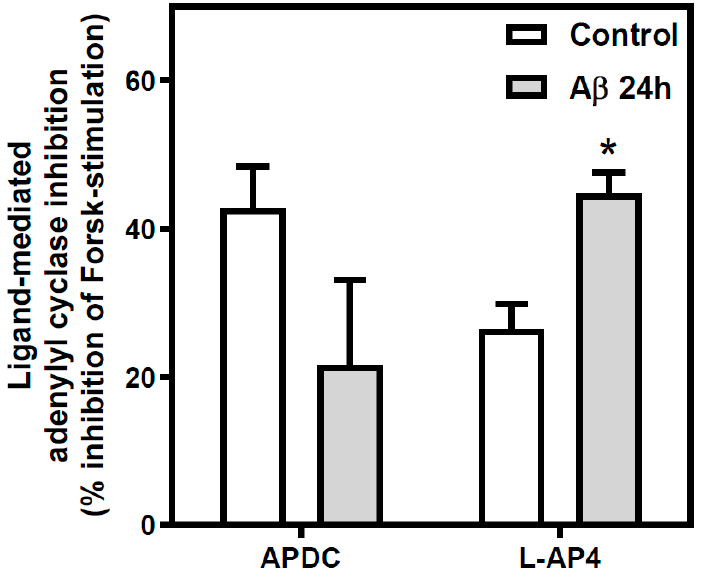
Figure 4. Effect of A β 25-35 treatment on Group II and III mGluR-mediated adenylyl cyclase pathway in cortical neurons. Inhibition of AC was measured in intact neurons exposed to 25 µM A β 25-35 for 24 h or maintained under control conditions. Control and treated cells were incubated in the presence of forskolin (5 µM) and in the absence or in the presence of 100 µM (2R,4R)-APDC or 100 µM L-AP4, specific group II and group III mGluR agonists, respectively. A β 25-35 exposure increased Group III-mediated inhibition of the forskolin-stimulated AC activity in cortical neurons. Data are means ± SEM of, at least, three independent experiments performed in duplicate using different preparations. All data were significantly different (at least p < 0.05) from their respective forskolin- stimulated value. Basal values: control 2.91 ± 0.60; A β 25-35 treated 2.33 ± 0.55 pmol/mg·min. * p < 0.05 significantly different from untreated condition using two tailed Student´s t -test.